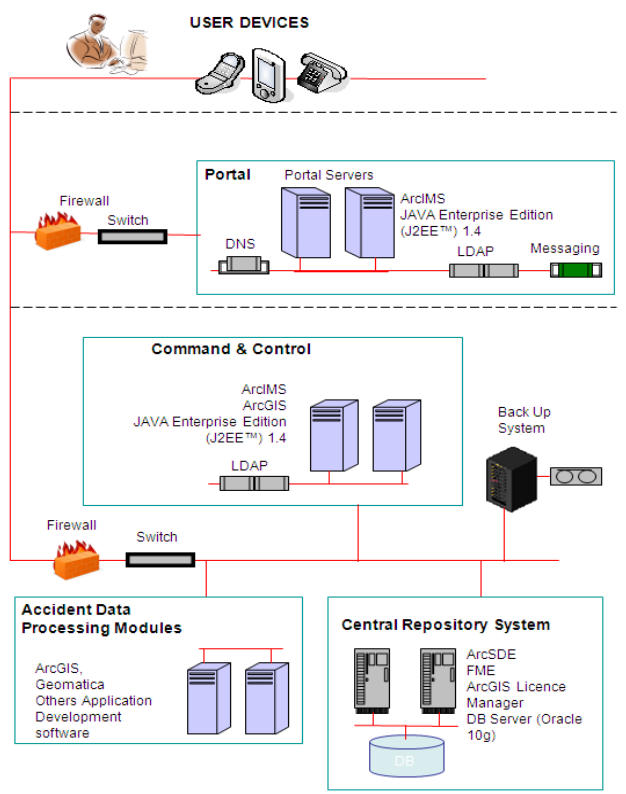
Figure 2. Landslide Monitoring and Management System